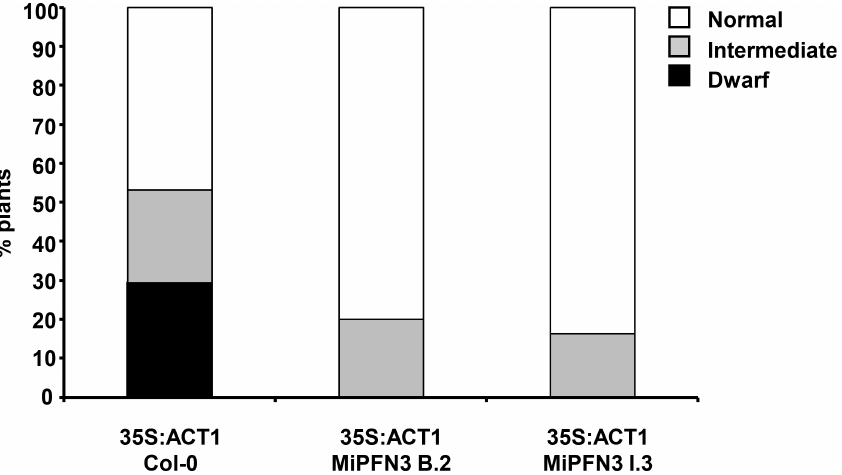
Fig 6. MiPFN3 expression in plants suppresses the AtACT1-induced dwarf phenotype. Col-0 and transgenic MiPFN3 lines were transformed to express 35s :: ACT1 .The growth phenotype of individual T1 plants was determined 5 weeks after germination. The number of dwarf, intermediate-sized, and wild-type rosette sizes were counted and normalized into a percentage of total plants (n = 109, 110 and 80